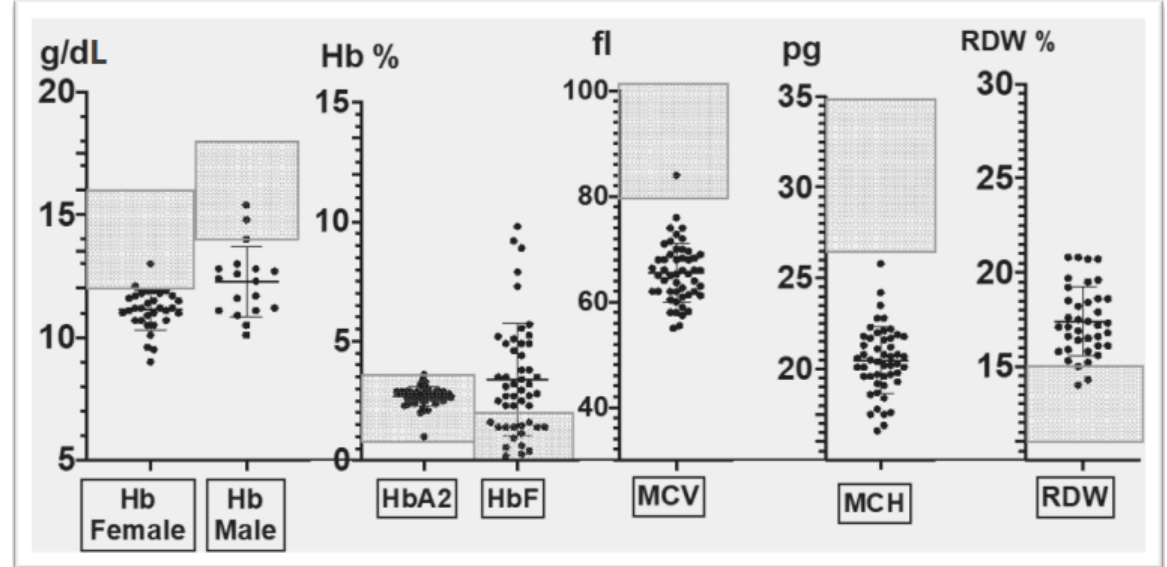
Figure 1. Definition of the hematological phenotype of Corfu δ ο β + ; assessment of relevant hematological and biochemical parameters in 50 Corfu δ ο β + thalassemia heterozygotes; shaded areas correspond to normal range.